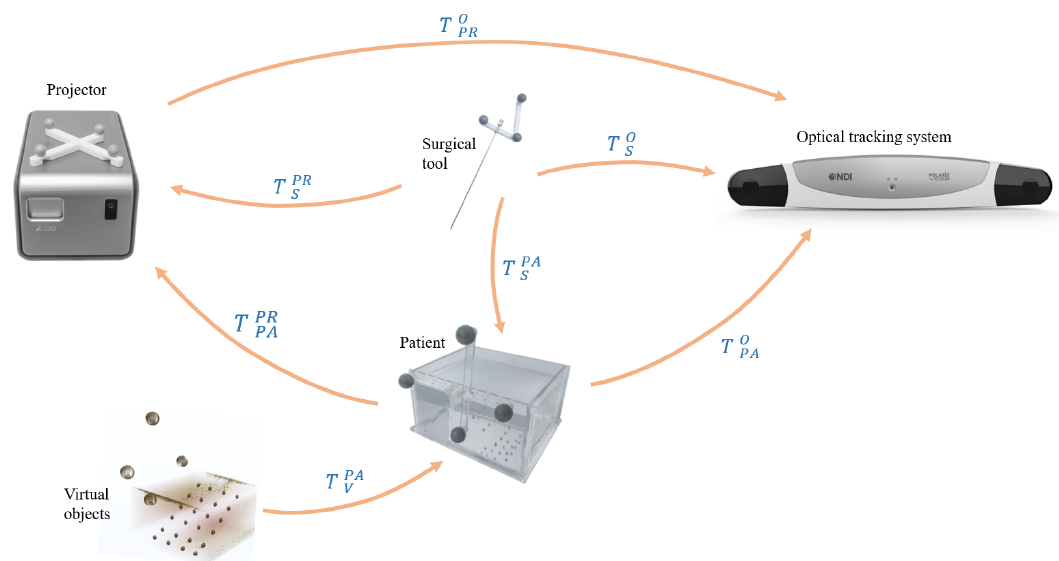
Figure 3. Different coordinate systems involved in our system: the virtual objects were registered to the patient, and the patient was then aligned with the projector’s reference, which is also the base of the virtual environment. The surgical tool was aligned to the projector’s reference for display, and aligned to the patient to compute the